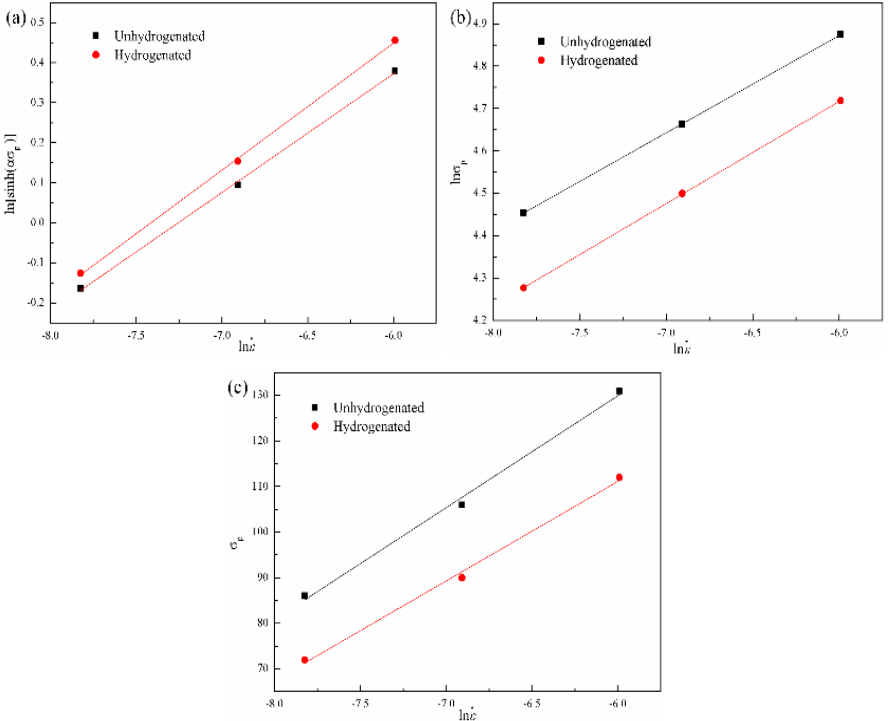
. ε Figure 7. Relationships between σ p and of the unhydrogenated and hydrogenated alloys: Figure 7. Relationships between σ p and ε  of the unhydrogenated and hydrogenated alloys: ( a ) . ε . ε . ε ( a ) ln[sin h ( ασ p )]–ln ; ( b ) ln σ p –ln and ( c ) σ p –ln relationships. ln[sin h ( ασ p )]–ln ε  ; ( b ) ln σ p –ln ε  and ( c ) σ p –ln ε  relationships.